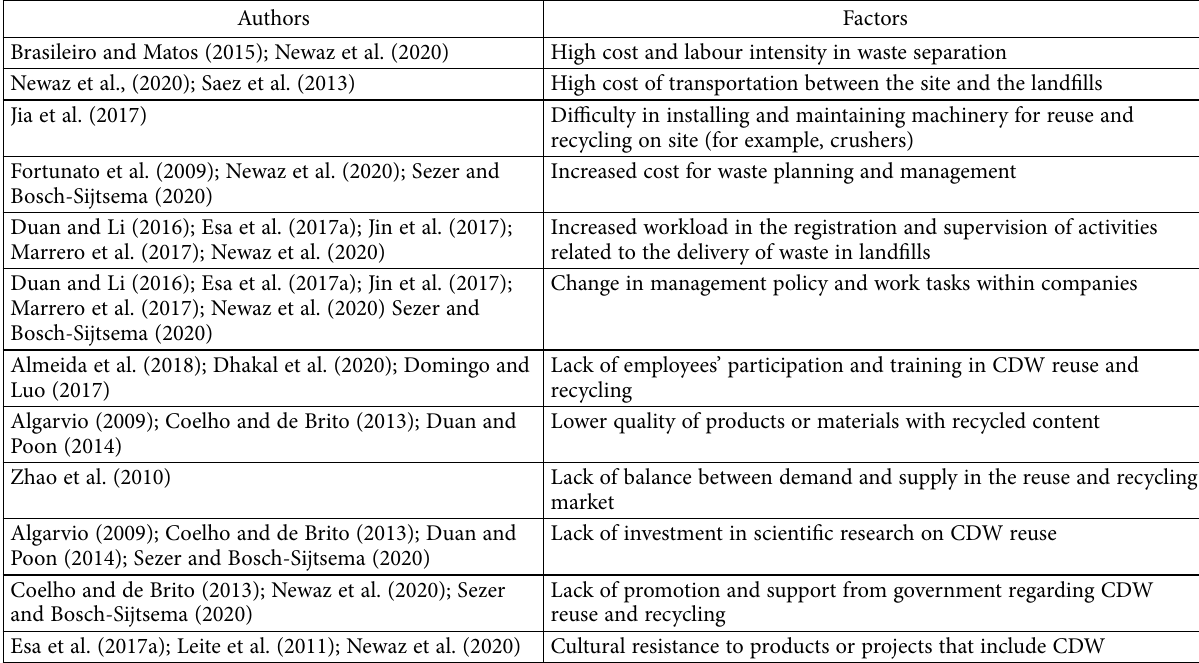
Table 2. Factors that hinder the practice of CDW reuse and